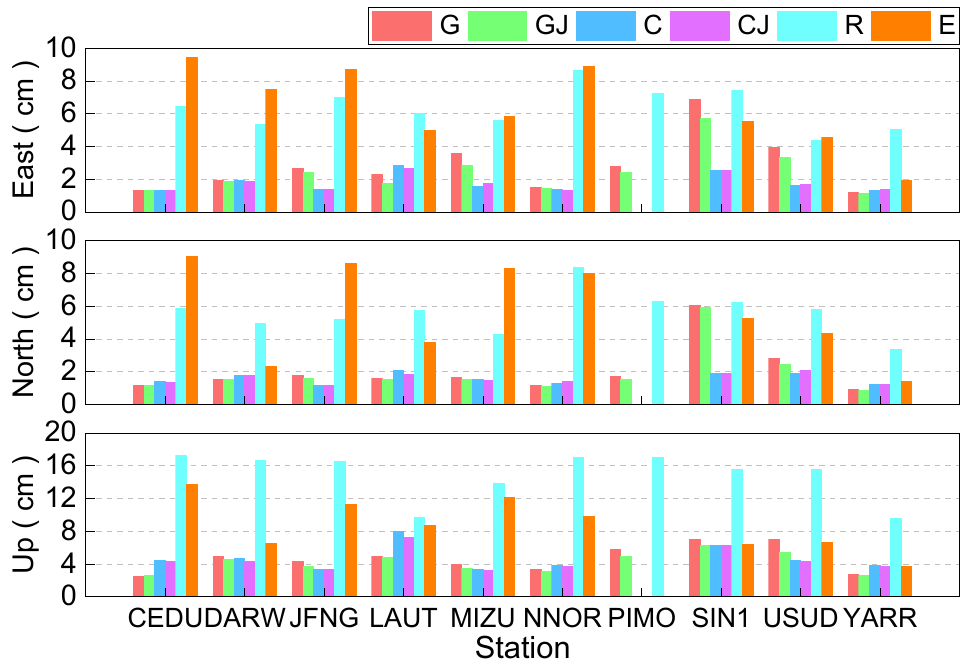
Figure 12. Positioning accuracy of kinematic PPP for each station.